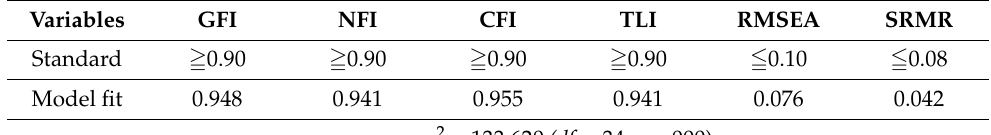
Table 3. Fit of the measurement tool.